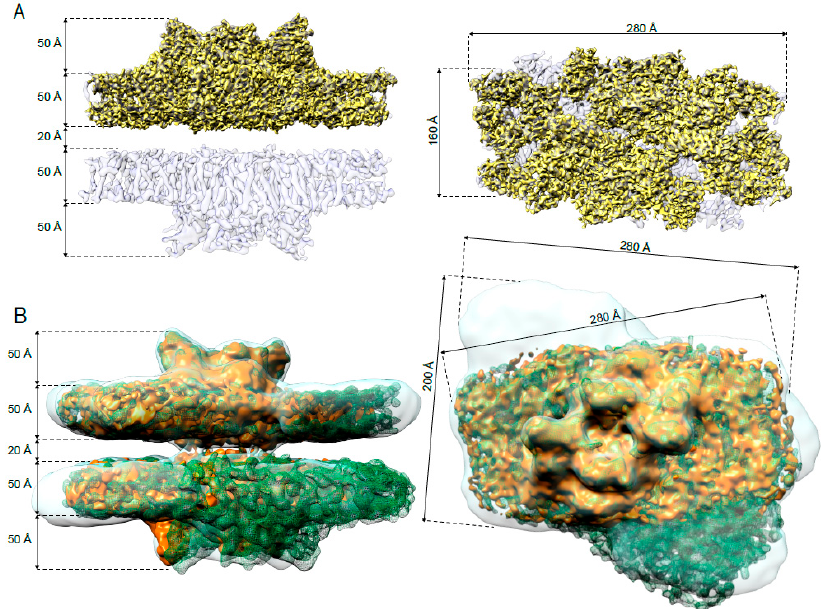
Figure 1. Comparison of the main representative paired PSII-LHCII supercomplexes isolated from plants grown in high-light and low-light. ( A ) Cryo-EM density map of the (C 2 S 2 ) 2 -H at 6.5 Å (light violet) with embedded the cryo-EM density map of the C 2 S 2 -H at 3.8 Å (yellow). ( B ) Overlay of the cryo-EM density maps of the (C 2 S 2 ) 2 -H at 8.4 Å (orange), (C 2 S 2 M) 2 -H at 11 Å (green mesh) and (C 2 S 2 M 2 ) 2 -L at 13.1 Å (transparent light blue). In both panels, the side view (on the left) is along the membrane plane; the top view (on the right) shows the PSII from the lumenal side, normal to the membrane plane.